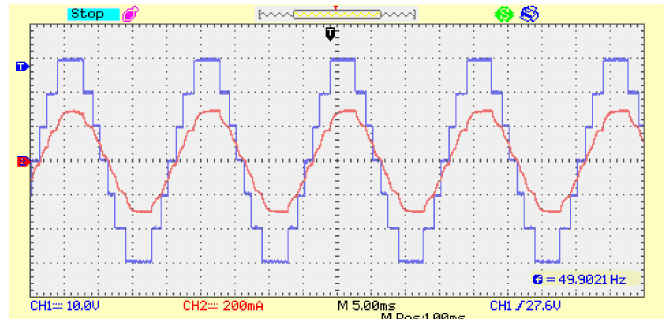
Figure 11. Experimental waveforms of voltage and current for phase A.